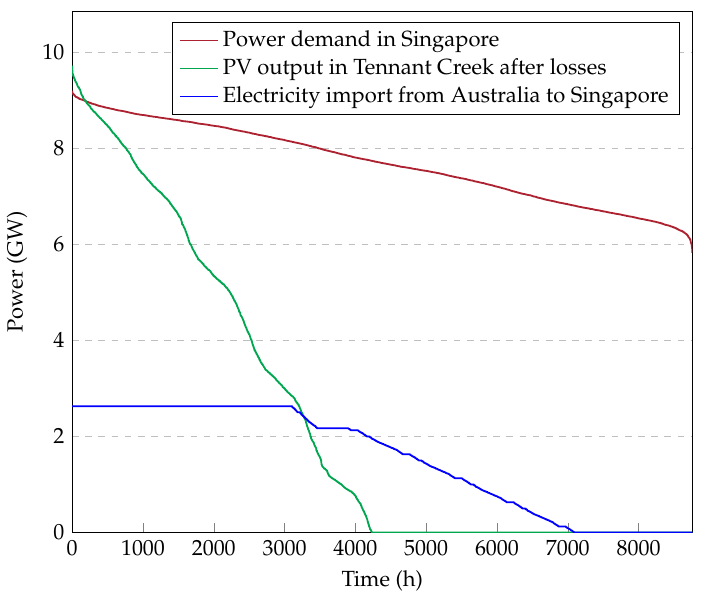
Figure A3. Sorted annual load duration curve of Singapore (maroon), PV system output in Tennant Creek (green), and imports through the HVDC cable (blue). The effect of the battery system is clearly visible in the extension of the time window of solar supply. The ramping constraint at the point of entry in the Singaporean grid affects the slope of the blue curve (roughly between hours 4000 and 7000). If the constraint is stricter, the blue curve is flattened even further, which means that the batteries have to be larger and the HVDC cable can be marginally